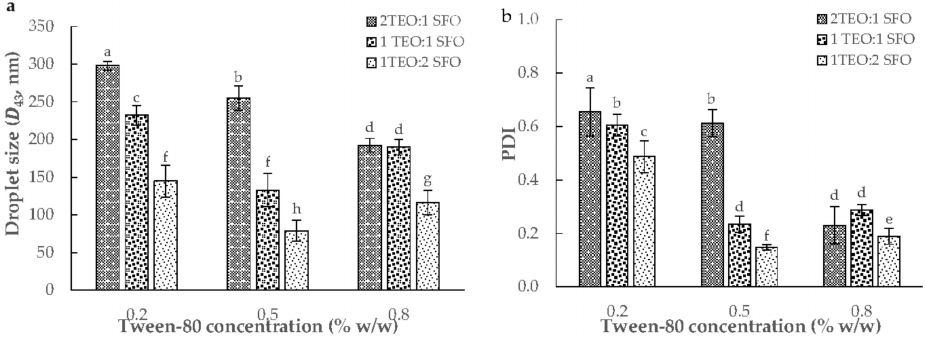
Figure 1. The volume-weighted mean diameter ( D 43 , ( a )) and polydispersity index ( PDI , ( b )) of TEO-NEs as a function of TEO/SFO ratio and surfactant concentration. (a–h) indicate the significant statistical difference ( p < 0.05).